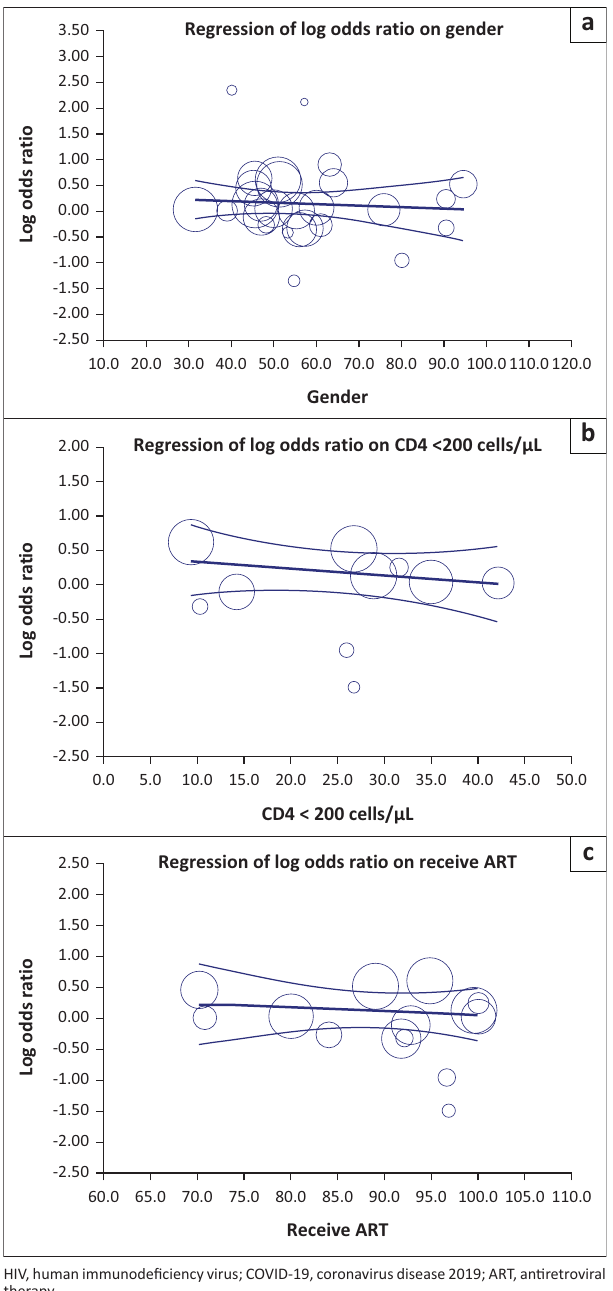
FIGURE 4: Funnel plot for the association of HIV with mortality from COVID-19